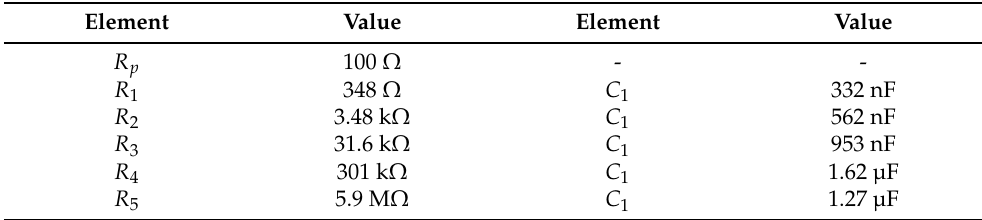
Table 1. Passive elements of a Foster-I network for approximating a fractional-order capacitor with pseudo-capacitance C α =1 µF and order α = 0.8.